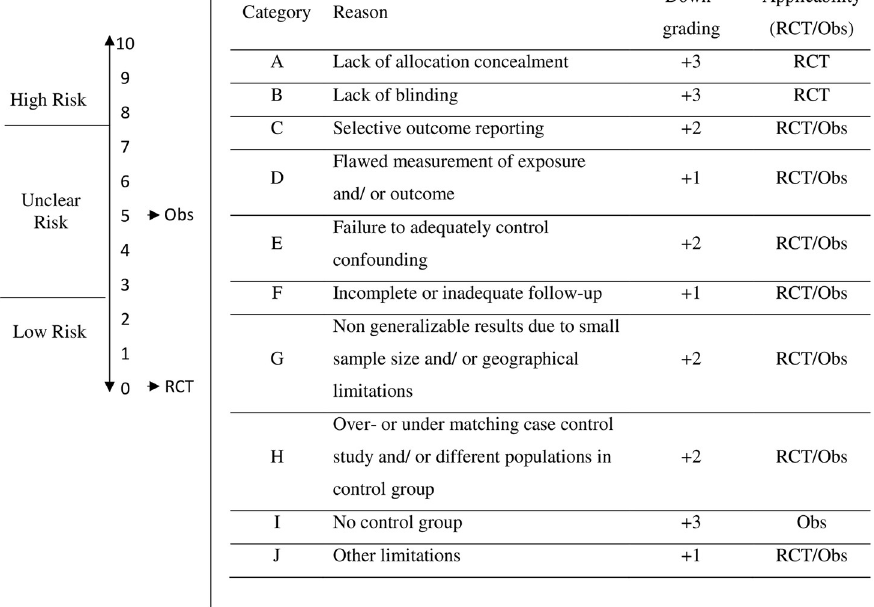
Fig 3. Risk of bias assessment based on GRADE assessment. Note . Starting point for RCTs is “Low Risk” with 0 points. Starting point for Obs is at “Unclear Risk” with 5 points. For each limitation, the corresponding downgrade (+1, +2, +3) is made on the scale (0 to 10), which results in the categorization of the risk of bias (Low, Unclear, High). Downgrading scores and categorization to low, unclear, and high risk were defined by